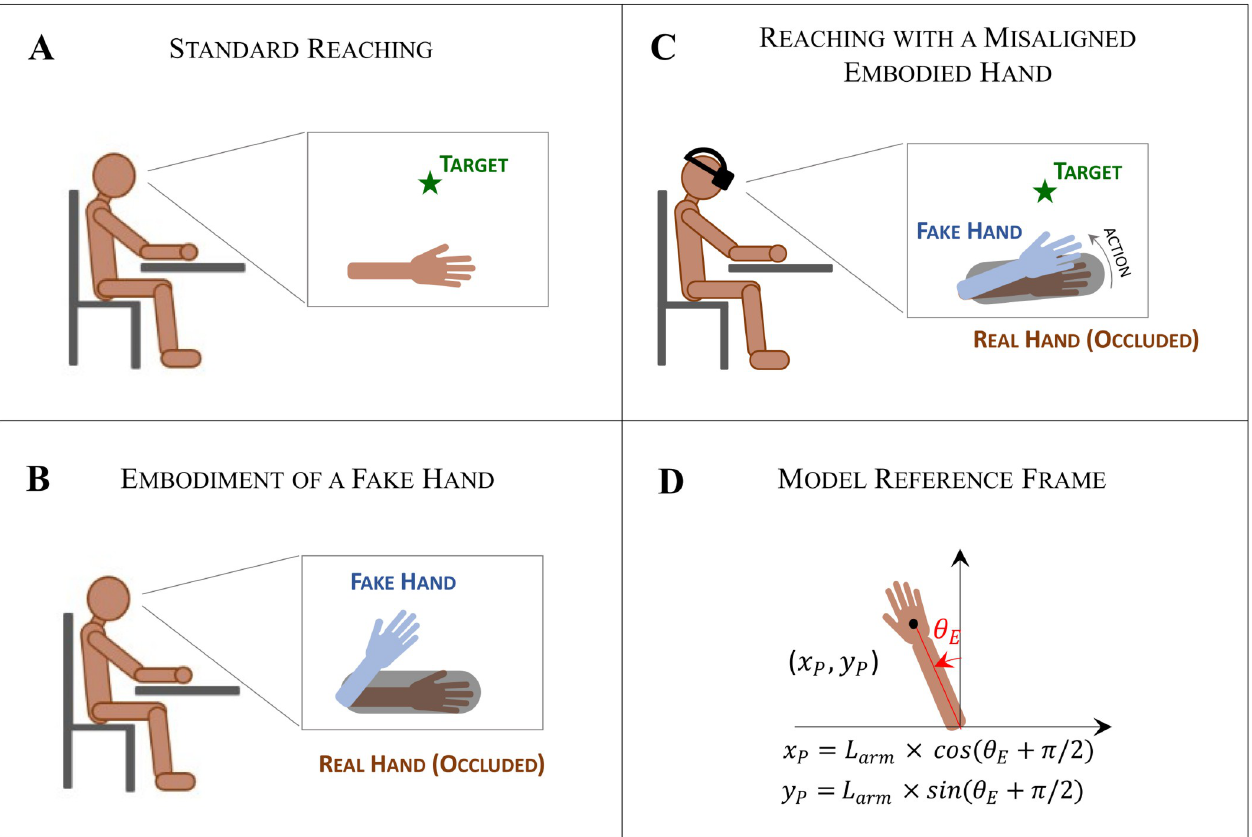
Fig 1. The simulation setup. (A-C) The three simulations included in the study. In all cases, the agent is seated with the forearm on the table. (A) In the first simulation, the agent has direct visual access to the real hand or equivalently, to a virtual hand projected to spatially overlap the actual hand position. (B) In the second simulation, the agent embodies a static fake hand placed in a configuration different from the real hand, hidden from view. (C) In the third simulation, the agent embodies a virtual arm seen through a stereoscopic visor and has to reach a target; the simulation includes a manipulation of the visuomotor mapping that, as the agent moves, introduces a spatial misalignment between the two hands. (D) In all the simulations, the agent is in control of one degree of freedom of the elbow, which can rotate along the vertical axis. The agent state is then uniquely described by the elbow joint angle θ visual representation of the end-effector specified in Cartesian coordinates ( x p , y p